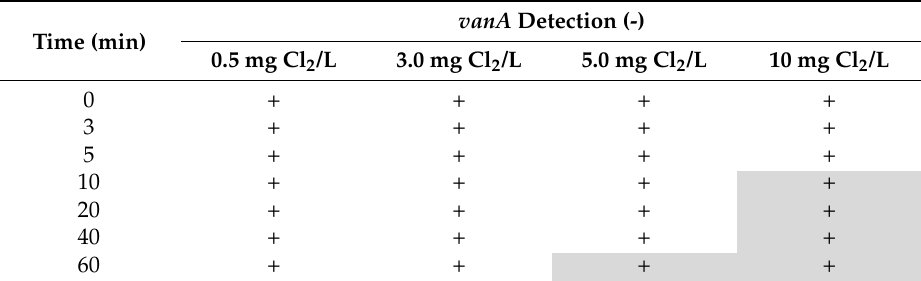
Table 4. vanA detection in each initial chlorine concentration and treatment time (VRE suspended in secondary effluent).